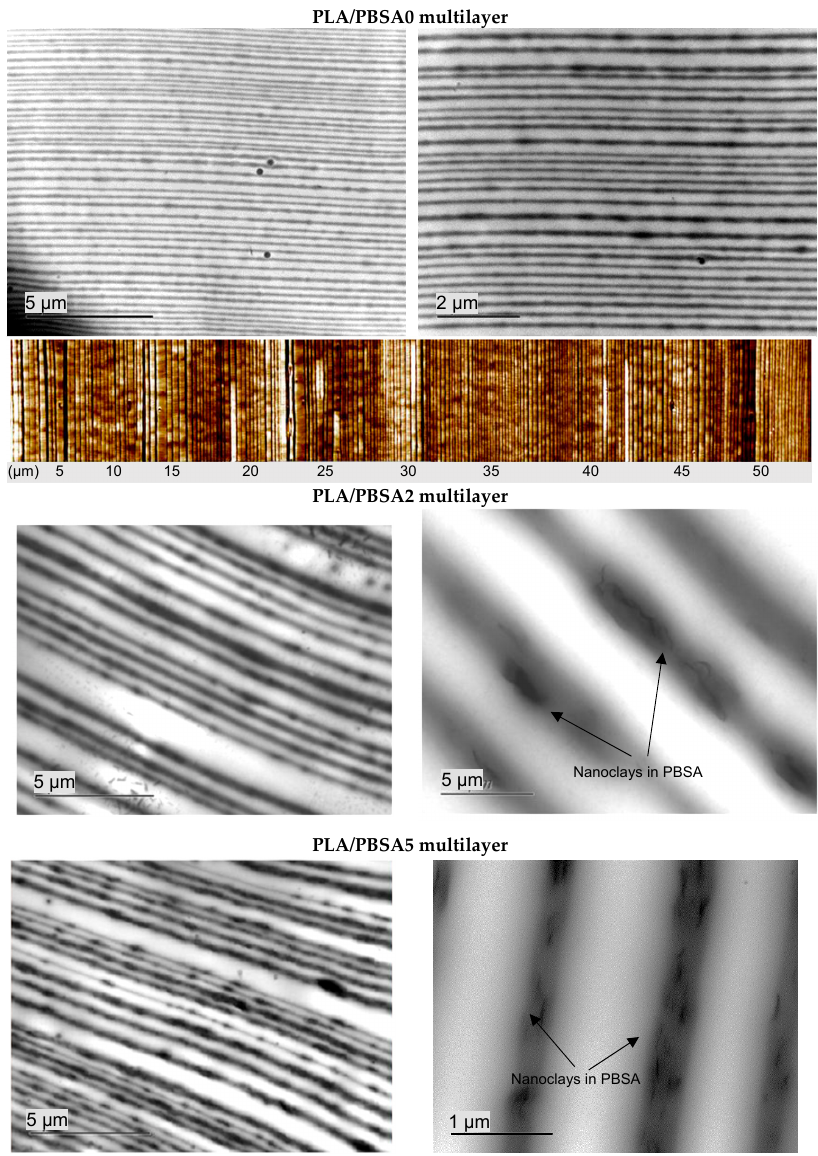
Figure 7. TEM observations of the unfilled PLA/PBSA and filled PLA/PBSA2 and PLA/PBSA5 multilayer films (PLA in white, PBSA in dark). (AFM image of unfilled PLA/PBSA multilayer films).